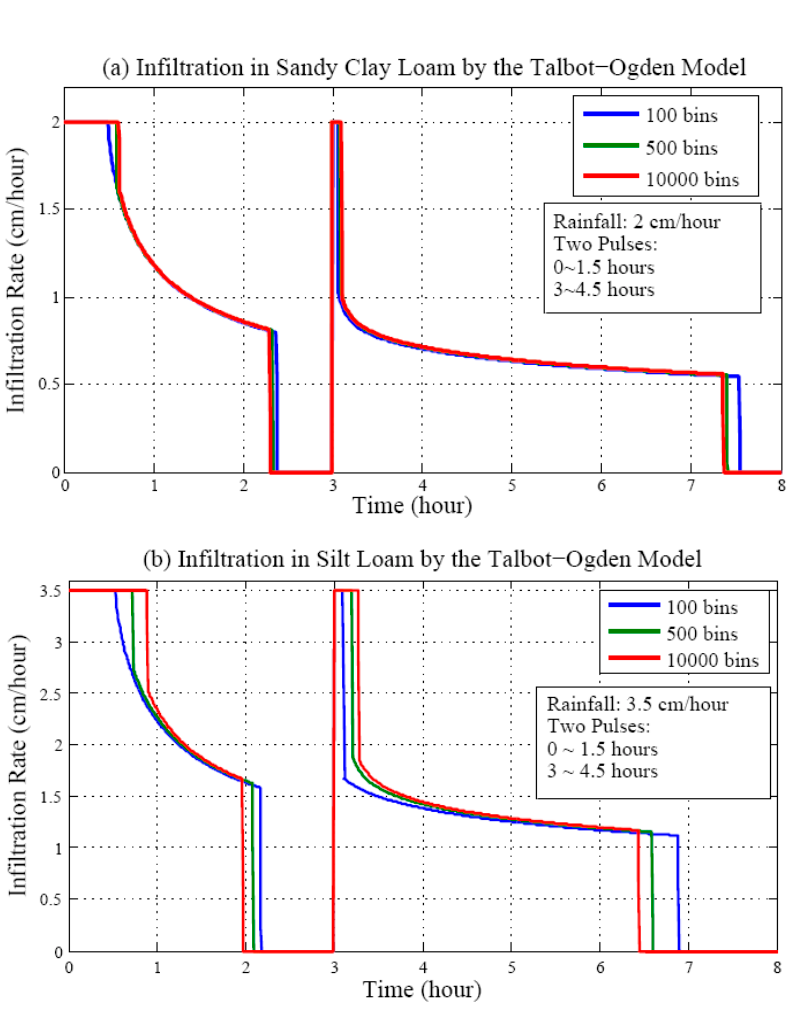
Figure 10. Infiltration in ( a ) sandy clay loam, and ( b ) silt loam with a large increase in the number of bins.